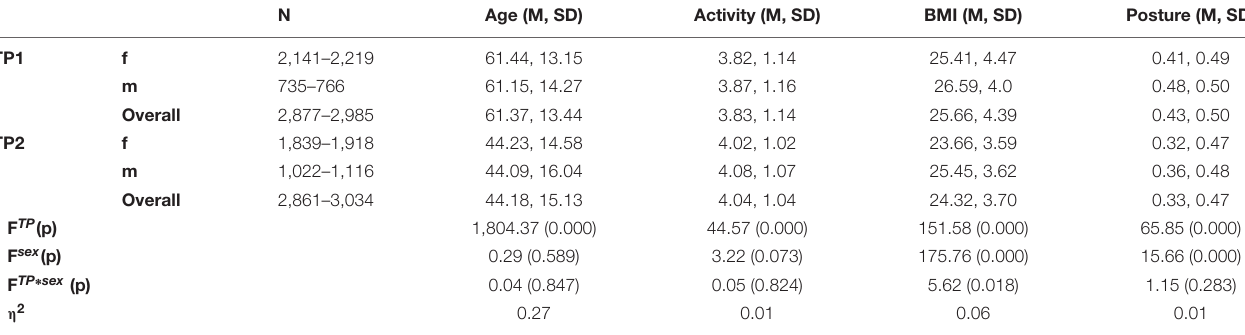
TABLE 2 | Results from two-factorial ANOVA on differences between TP1 and TP2 participants. N Age (M, SD) Activity (M, SD) BMI (M, SD) Posture (M, SD)